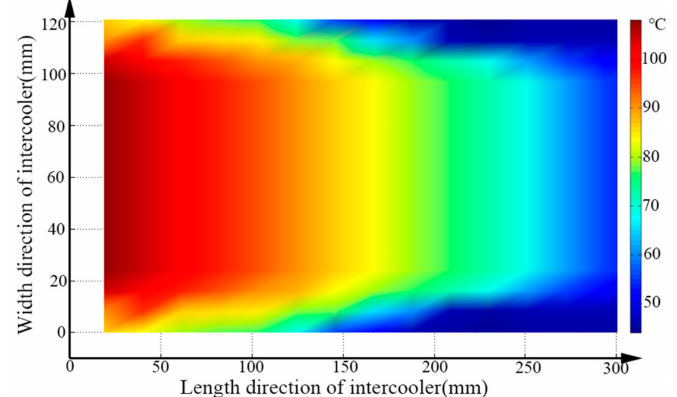
Figure 9. Airside temperature field of two-pass water-cooled charge air